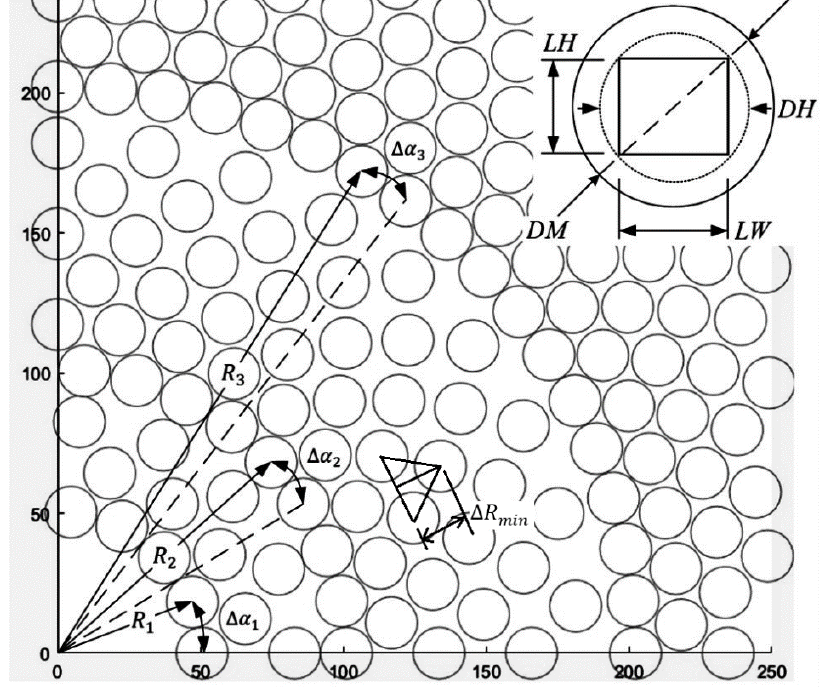
Figure 3. A snapshot of a section of heliostat field generated with the essential variables.